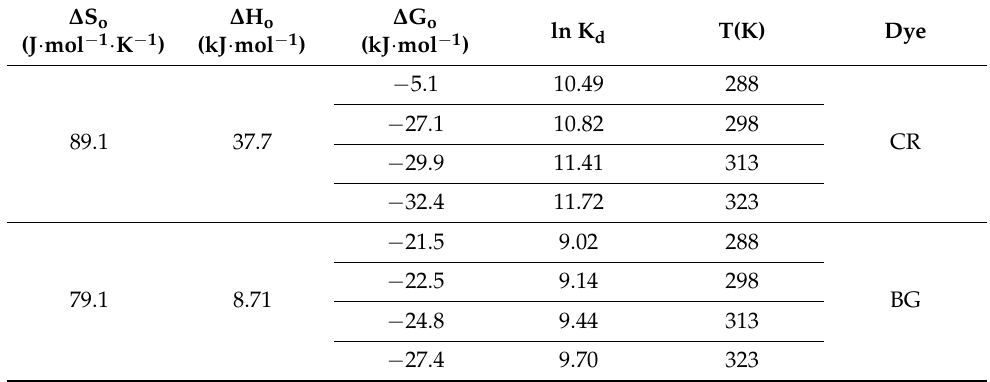
Table 3. Thermodynamic data for the adsorption of CR and BG dyes on the NLS/Cs/Alg. nanocomposite.